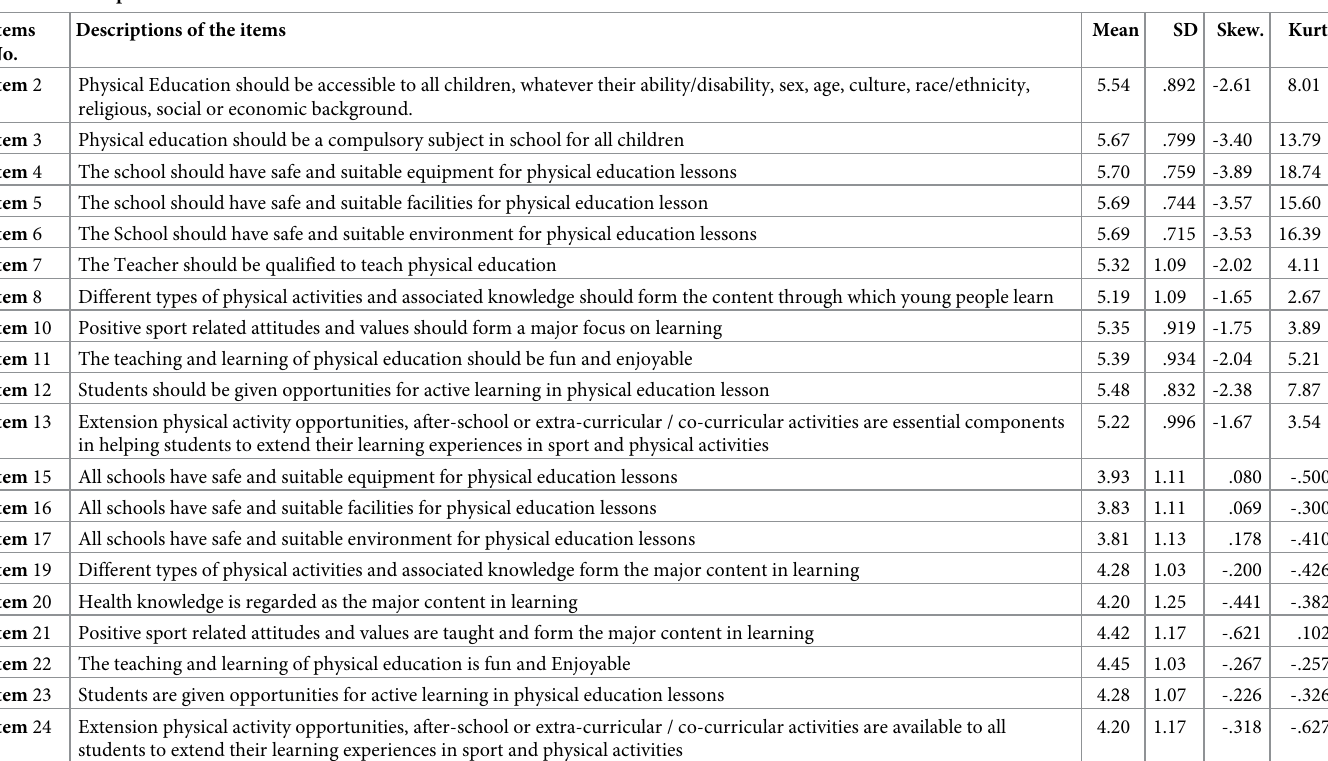
Table 3. Descriptive statistics on all the retained